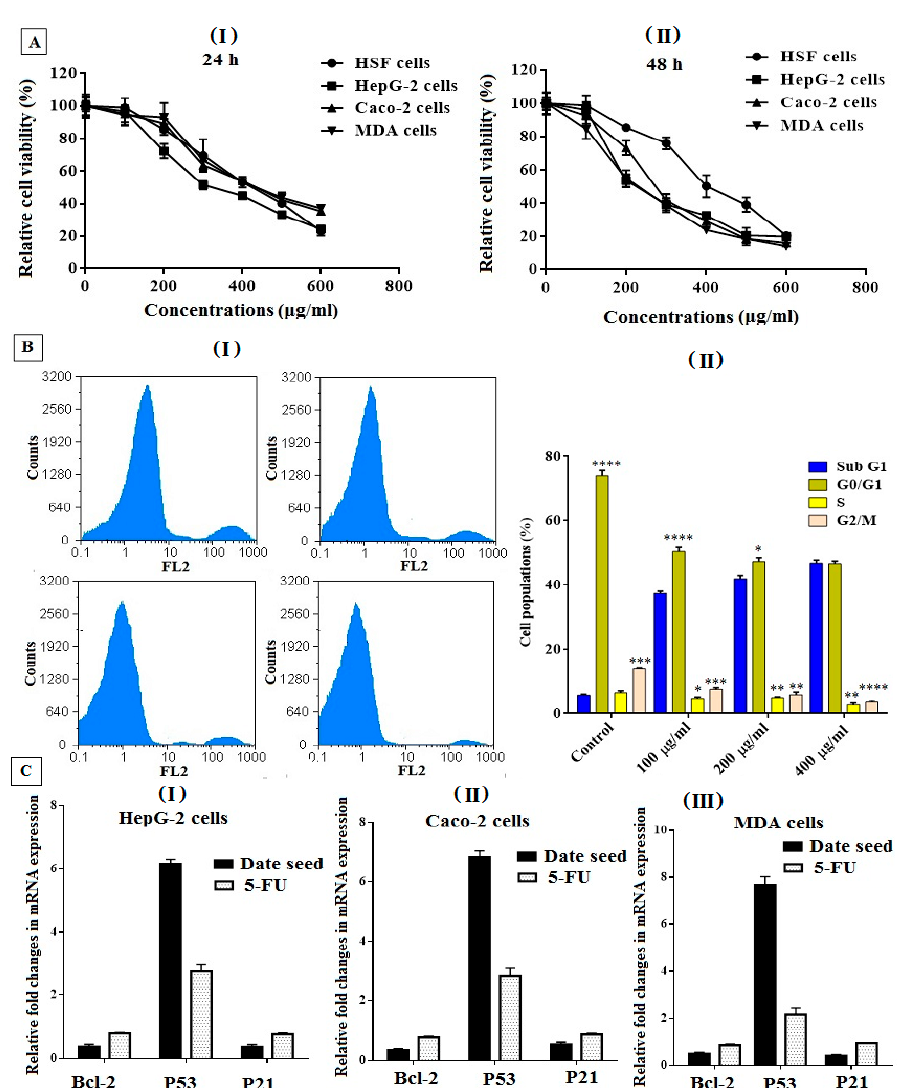
Figure 5. ( A ) DSE effect on the viability of cancer (MDA, HepG-2, and Caco-2) and normal (HSF) cell lines using the MTT method. All cell lines were incubated with DSE at different concentrations (0–600 µ g/mL) for 24 h ( I ) and 48 h ( II ). All values are expressed as mean ± SEM; n = 3. ( B ) Cell cycle distribution of DSE-treated HepG-2 cells at different doses for 48 h, ( I ) cell cycle distribution diagrams (original flow charts), and ( II ) quantitative distribution of the cells treated with DSE in different phases of the cell cycle compared with untreated (control) cells. All values are demonstrated as mean ± SEM, and differences were considered statistically significant at * p < 0.05, ** p < 0.005, *** p < 0.0005, and **** p < 0.0001. ( C ) Relative fold change in the gene expression of BCl2, P53, and p21 in the DSE treated cells using qPCR. Angiogenesis-related genes are evaluated in HepG-2 ( I ), Caco-2 ( II ), and MDA ( III ) cells before and after treatment with the DSE compared with 5-FU for 48 h. Values are presented as mean ±